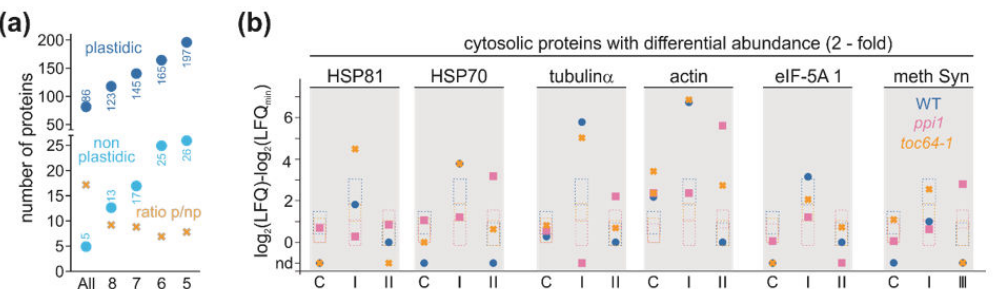
Figure 4. Protein abundance of non-plastidic proteins in chloroplast fractions after heat stress. ( a ) The number of plastid (p -localized (dark blue) or non-plastidic (np) proteins (light blue; based on SUBA) found in all, or in at least 8, 7, 6 or 5 chloroplast samples is shown. Yellow crosses indicated the ratio between plastid localized proteins and non-plastidic proteins. ( b ) The log 2 (LFQ) for the indicated protein group was normalized to the lowest log 2 (LFQ) value found for the indicated group in any of the samples. The value is plotted for the wild type (blue), ppi1 (magenta) or toc64-1 (yellow). The dotted frames indicate the 99% confidence interval of the median of the log 2 (LFQ) values normalized to the lowest median (control, HS-I, and HS-II) of all non-plastidic proteins in one